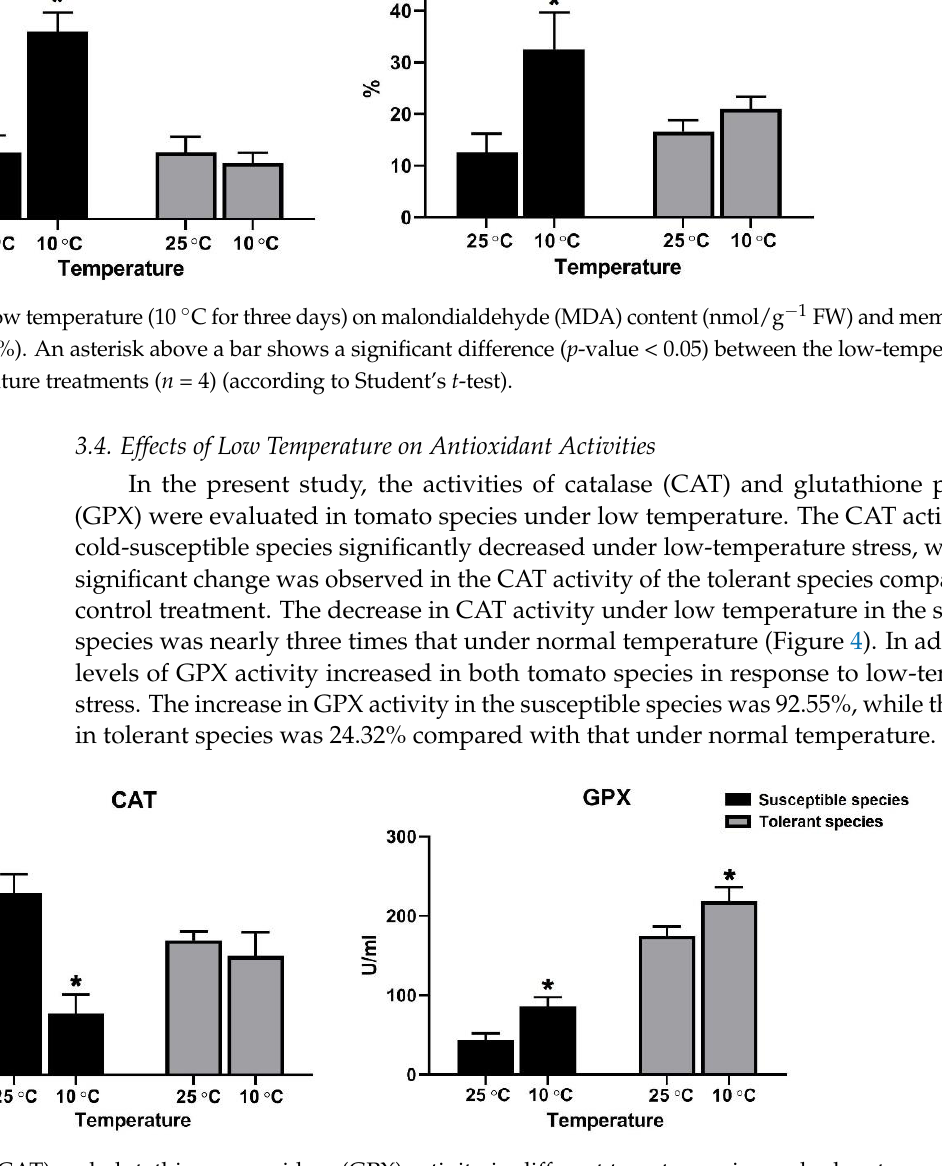
Figure 4. Catalase (CAT) and glutathione peroxidase (GPX) activity in different tomato species under low temperature (10 ◦ C for three days). An asterisk above a bar shows a significant difference ( p -value < 0.05) between the low-temperature and normal-temperature treatments ( n = 4) (according to Student’s t